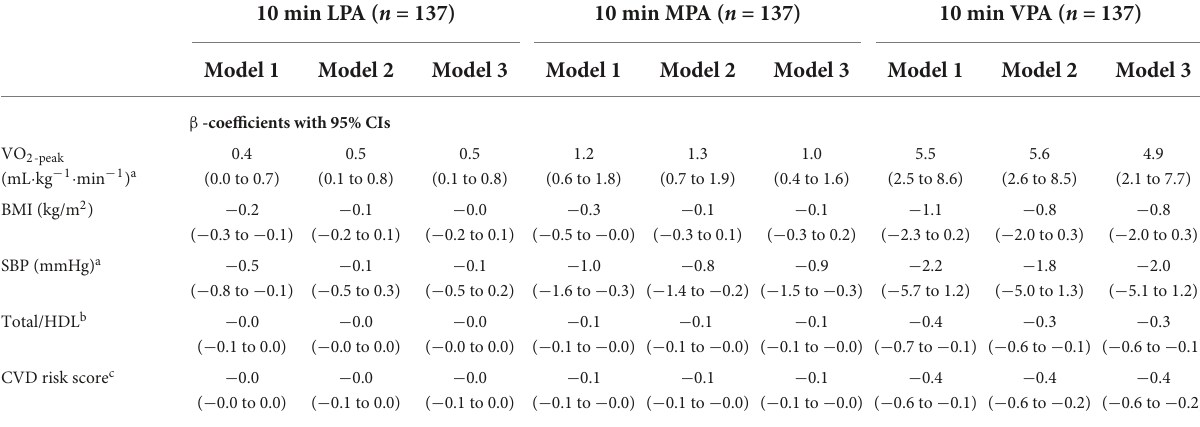
TABLE 4 Associations between 10-min increase in PA intensities and CVD risk factors in adolescent CCS. 10 min LPA ( n =